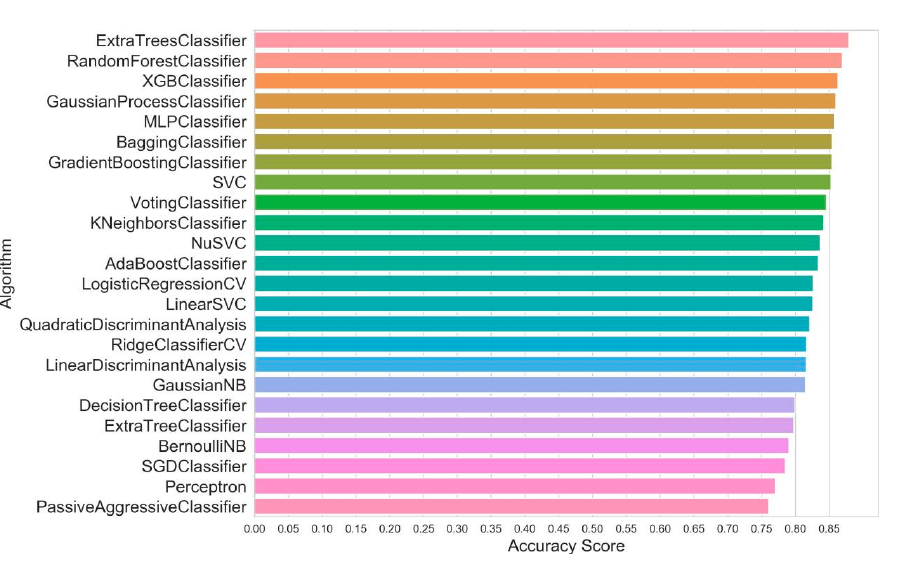
Figure 10. Ranking of Model Accuracy Scores.